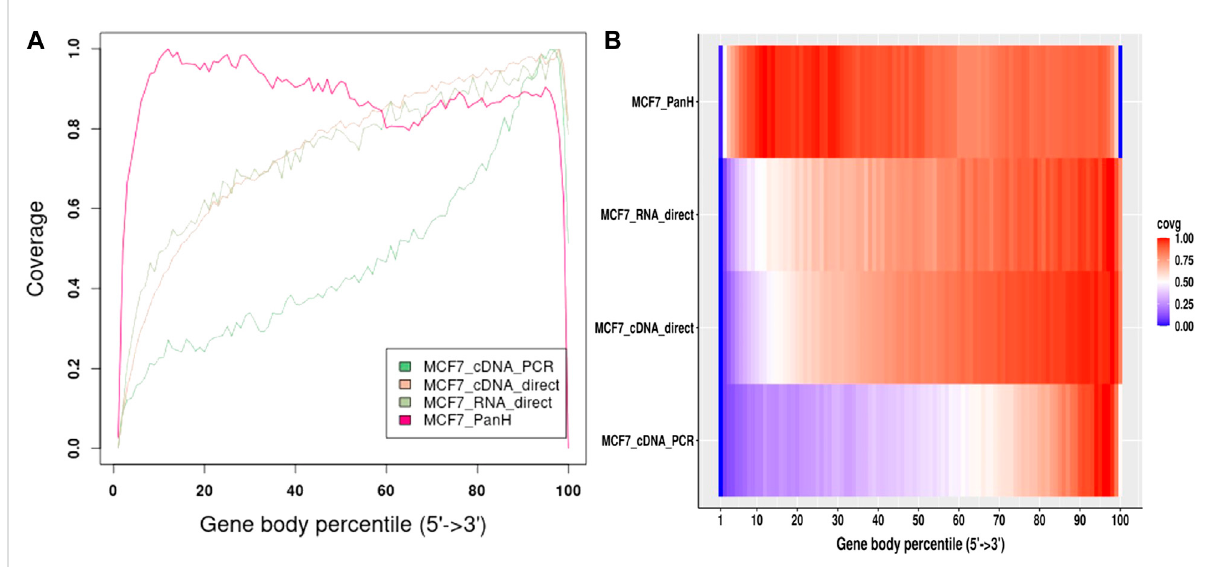
FIGURE 5 MCF7 Gene body coverage comparison betweenPanhandle protocol and previously published datasets. We downloaded previously published MCF7 datasets (Chen et al., 2021) that were sequenced through cDNA-PCR, direct cDNA sequencing (cDNA-direct), and direct RNA sequencing (RNA-direct) following Oxford Nanopore Techologies protocols. We aligned these reads to the T2T-CHM genome together with our MCF7 dataset generated through our Panhandle protocol and assessed gene body coverage using RSeQC (Wang et al., 2012). (A) Line graph showing gene body coverage using MCF7 cell lineand comparingourinhouseprotocol calledPanhandle(PanH) withother Oxford NanoporeTechnologies(ONT) RNA sequencing approaches. (B) Same data used in ‘ A ’ but represented as a Heat